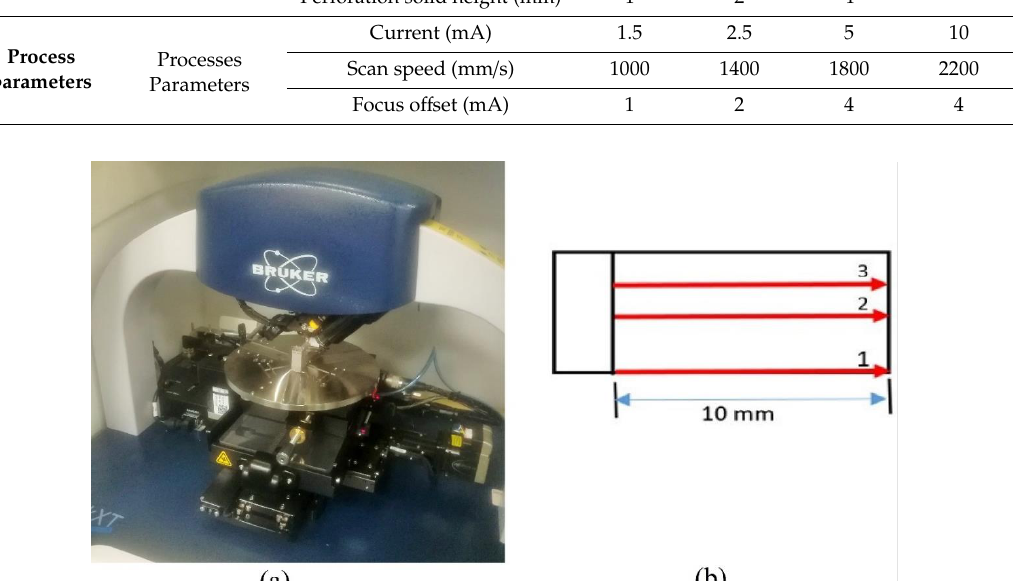
Figure 3. Surface roughness measuring ( a ) Dektak XT surface profiler; ( b ) specimen measured surface.